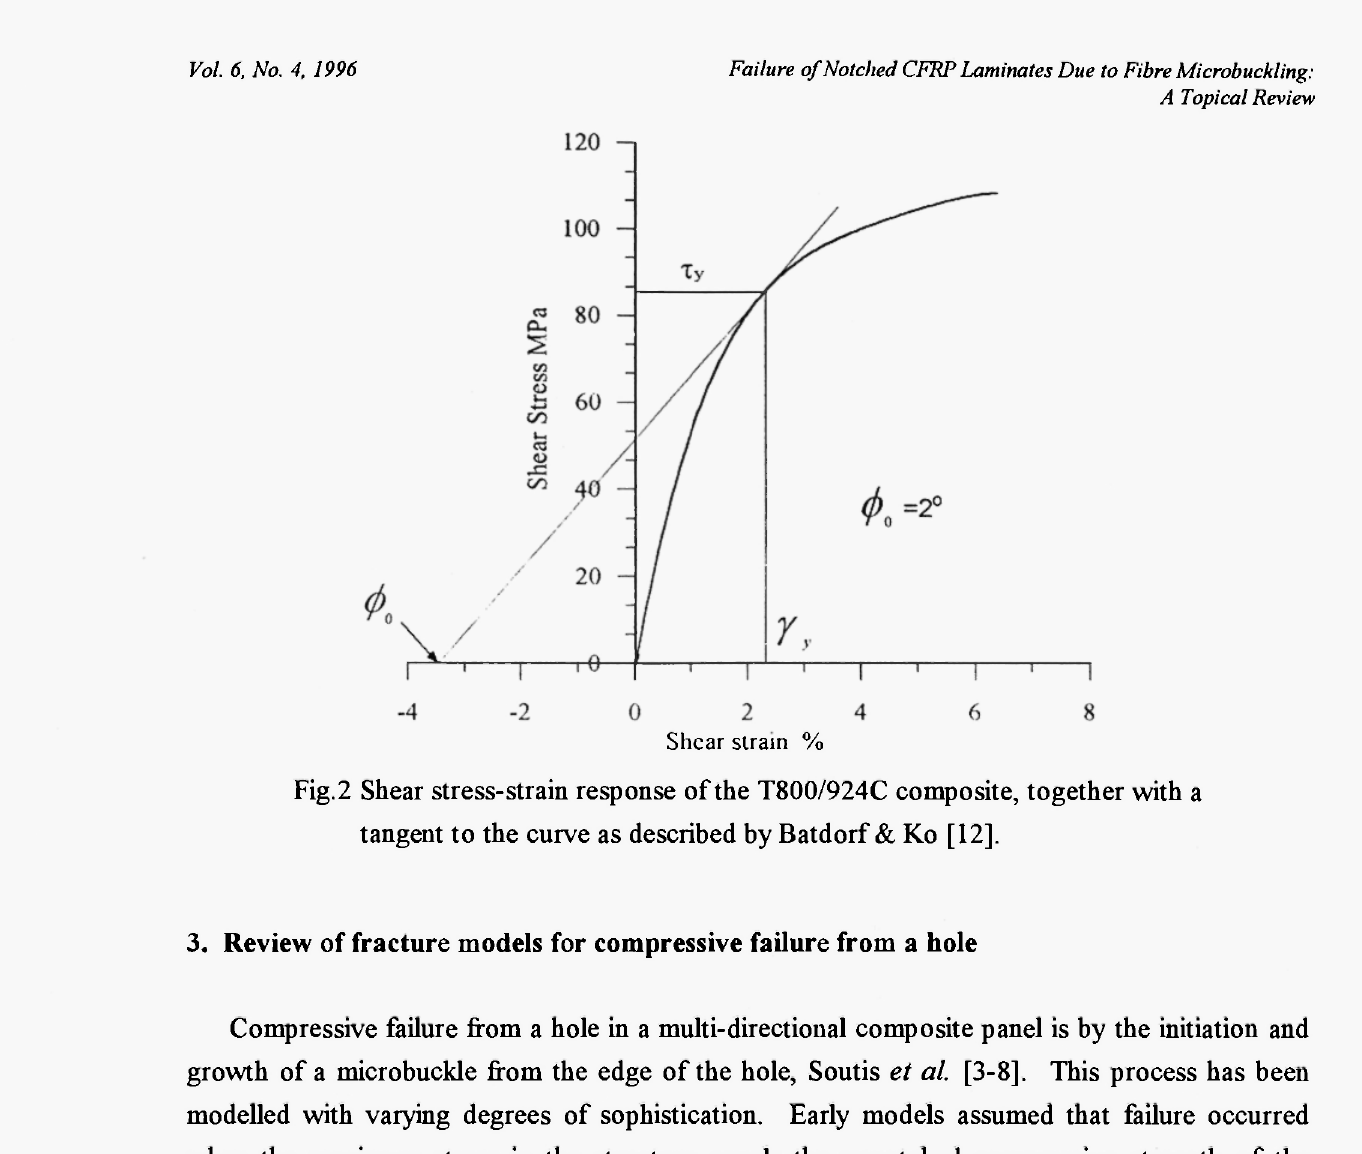
Fig. 2 Shear stress-strain response of the T800/924C composite, together with a tangent to the curve as described by Batdorf & Ko